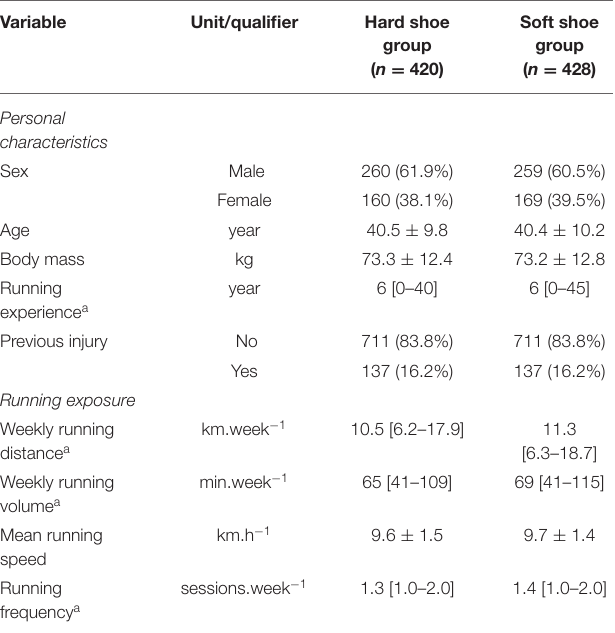
TABLE 1 | Descriptive statistics of the study participants ( n = 848).